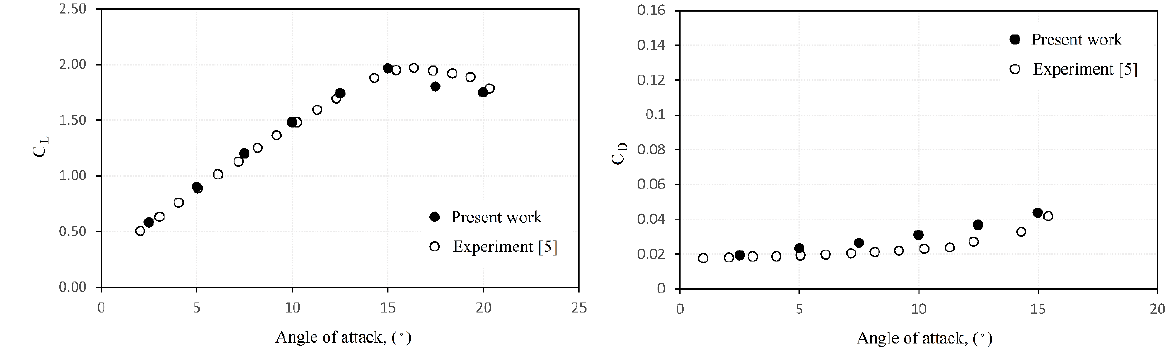
Figure 10. Comparison of lift and drag coefficients of the airfoil equipped with VGs with those of the experiment Figure 11 shows lift coefficient of the clean airfoil in the presence of Gurney flap attained from the present work and experiment [5]. Consistent with experiment, results are obtained for the airfoil DU93-W-210 at Reynolds number of 2×10 6 . As shown in Figure 11, there is a good concordance between the current research and experimental results.